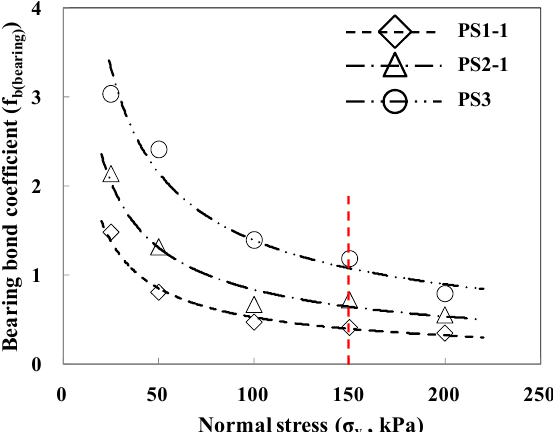
Figure 8. Relationship between normal stress and bearing bond coefficient.